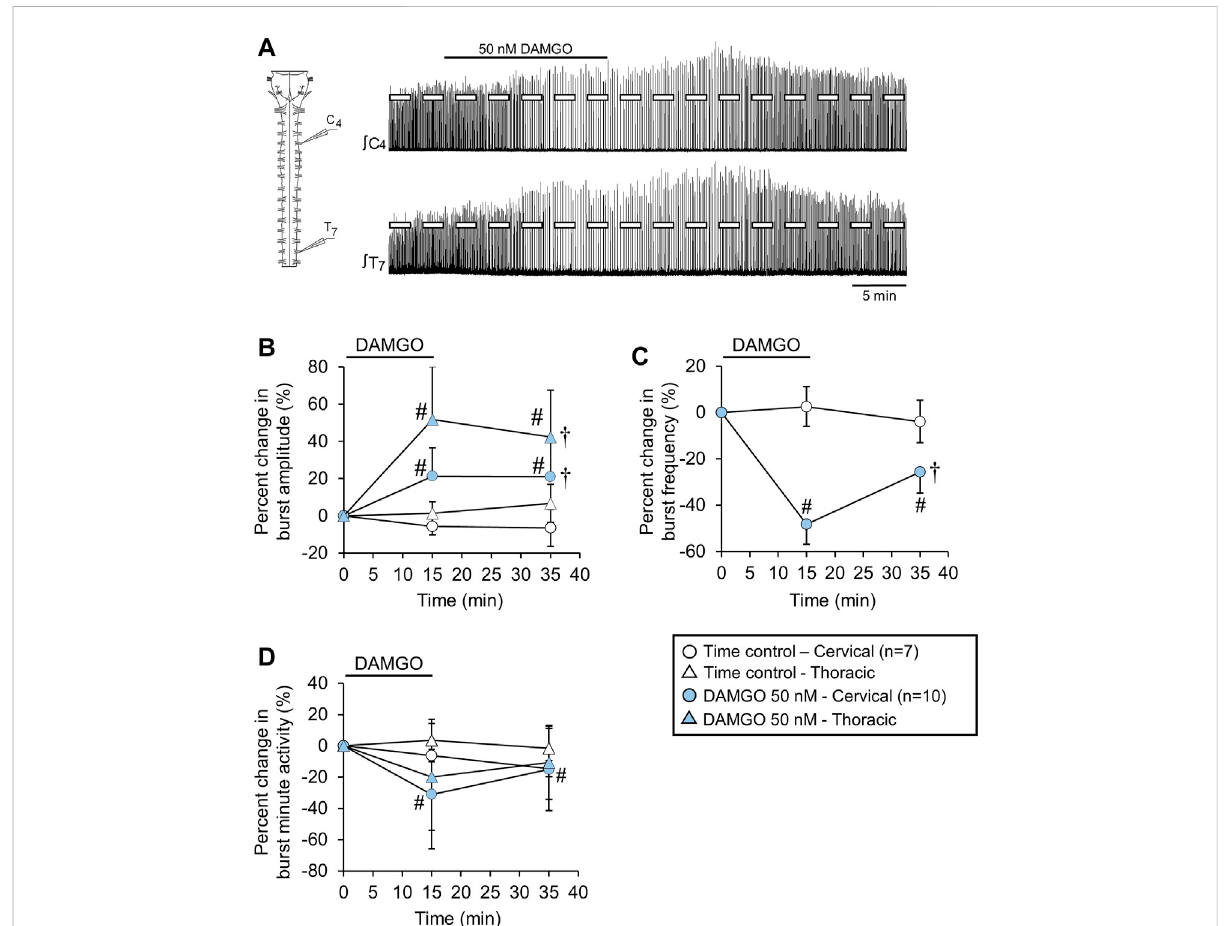
The DAMGO-induced inspiratory burst amplitude increase was expressed in motor output from the thoracic spinal cord. (A) Drawing of a brainstem-spinal cord preparation extended to thoracic spinal segment T8 with suction electrodes attached to ventral roots of spinal segments C4 and T7. At right are sample voltage traces showing inspiratory-related motor bursts in cervical (upper trace) and thoracic (lower trace) during a 50 nM DAMGO application. (B) Burst amplitude increased in both cervical (blue circles) and thoracic (blue triangles) spinal cord motor output. (C) Burst frequency was decreased by DAMGO. The decrease was identical for brainstem and spinal cord recordings (blue circles), while (D) minute activity was relatively unaltered by the DAMGO application except for the cervical motor output at the 15-min time point. The pound sign (#) indicates a signi fi cant pairwise comparison difference from time controls at that time point, and the dagger ( † ) indicates a signi fi cant overall DAMGO concentration effect. Data shown as mean ± SD. These data indicate that the inspiratory burst amplitude increase was not restricted to phrenic motoneurons in the cervical spinal